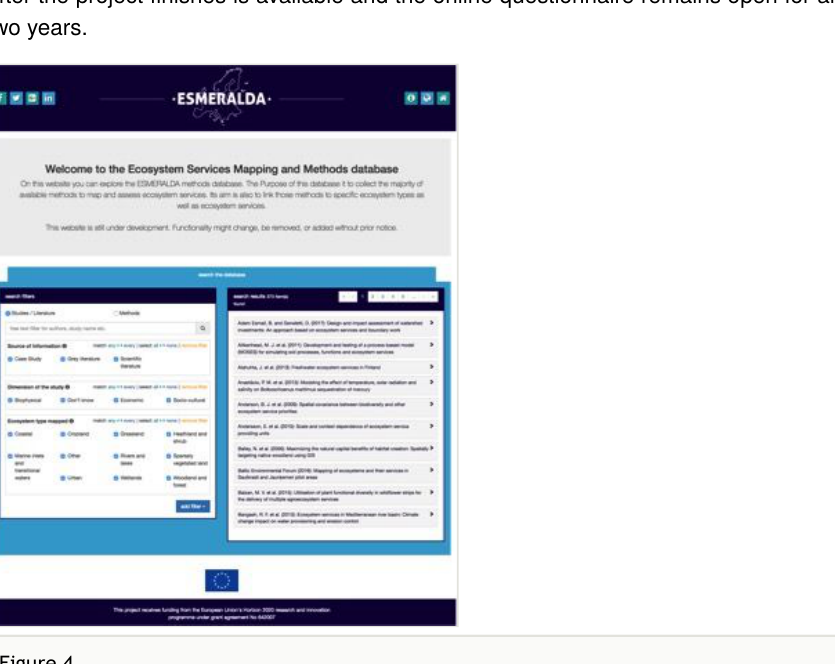
Figure 4. Developing the fi rst version of ESMERALDA database, which included scienti fi c and grey literature from ecosystem service mapping and assessment